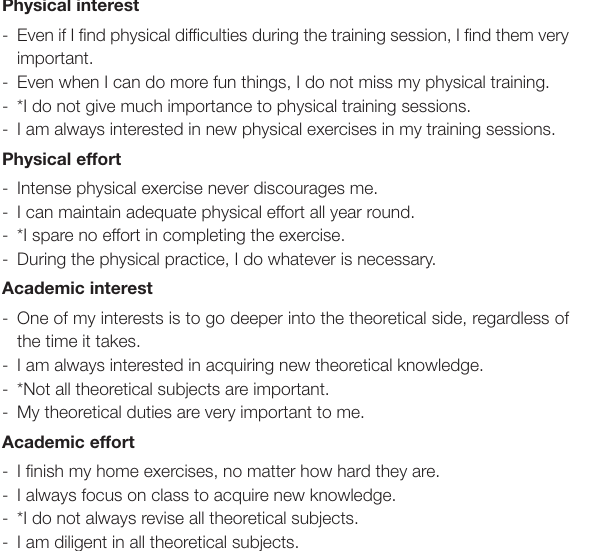
FIGURE A1 | The Arabic version of the